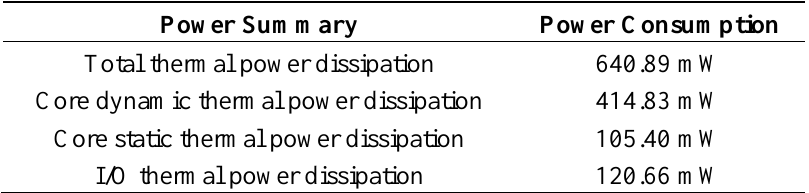
Table 5. FPGA implementation power